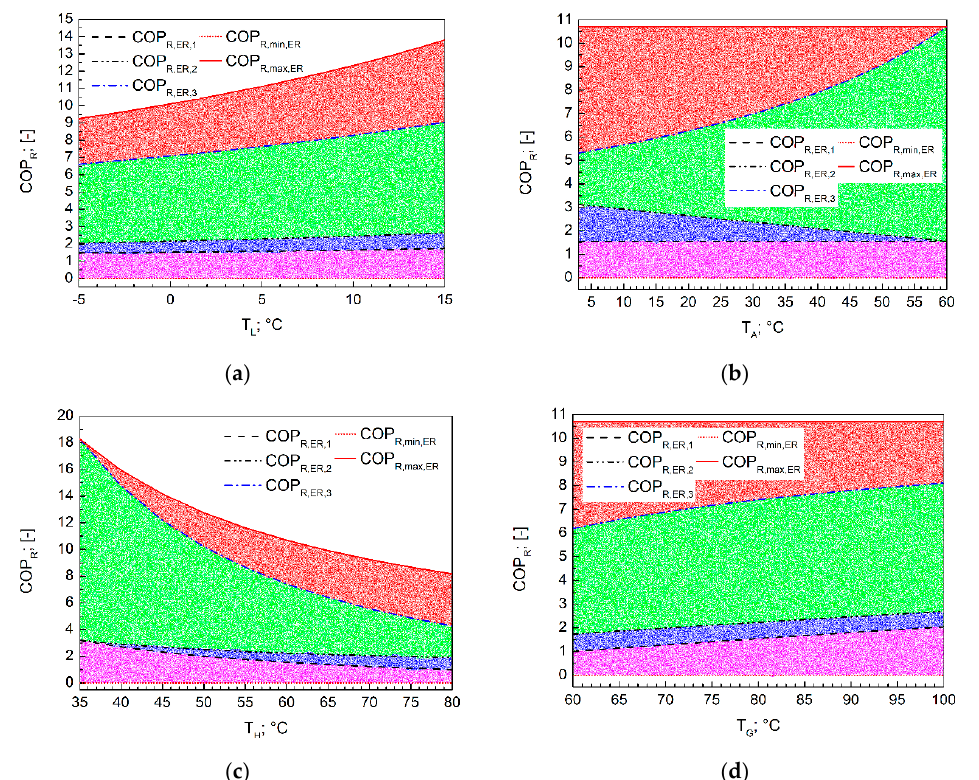
Figure 6. The coe ffi cient of performance as a function of ( a ) evaporation, ( b ) absorption, ( c ) condensation, and ( d ) generator temperatures in order to obtain a better performance of an absorption machine in comparison with a machine with a mechanical